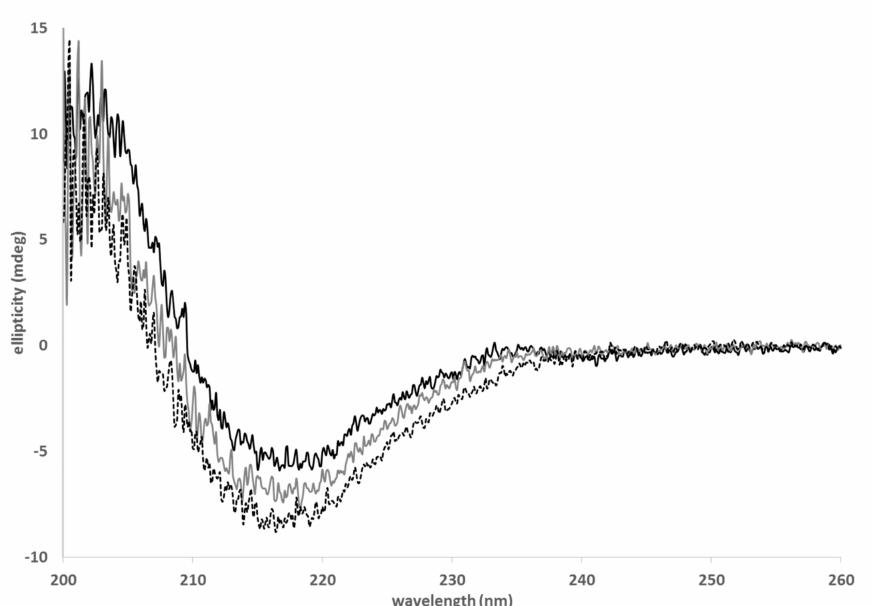
Figure 6. CD spectra of commercial BVZ (black), of BVZ in the presence of surfactants (grey), and of BVZ in the presence of surfactants and AOT (dotted black).